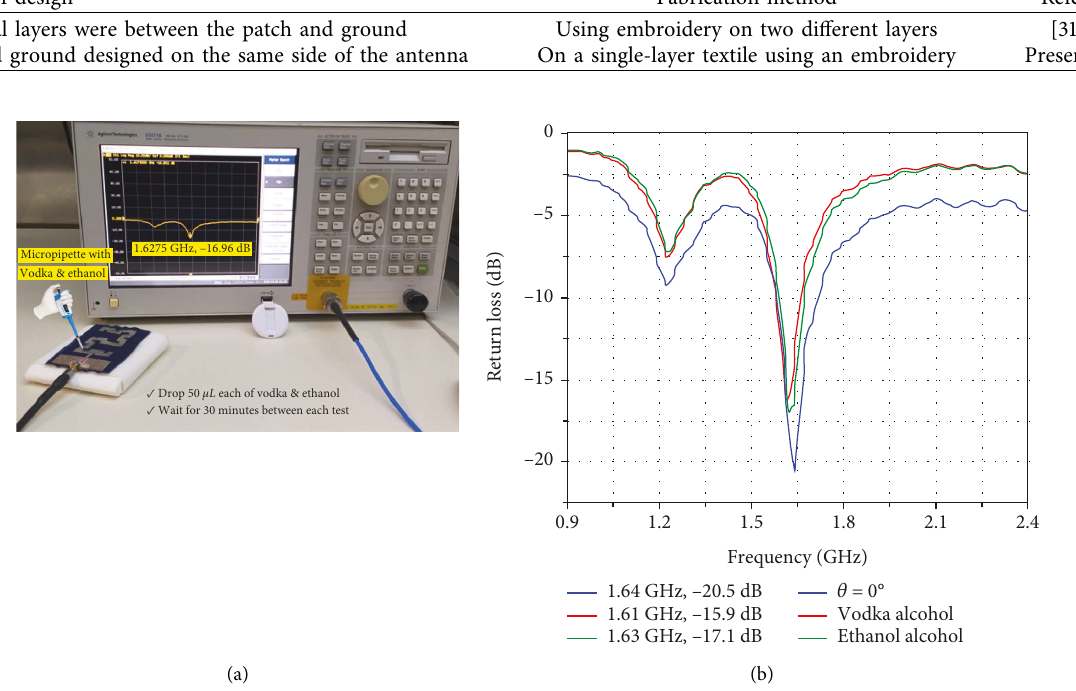
Figure 12: (a) Snapshot of measurement setup under accidental spills, and (b) return loss plot of the proposed textile antenna when wetted with 50 µ L each of ethanol alcohol and vodka alcohol.